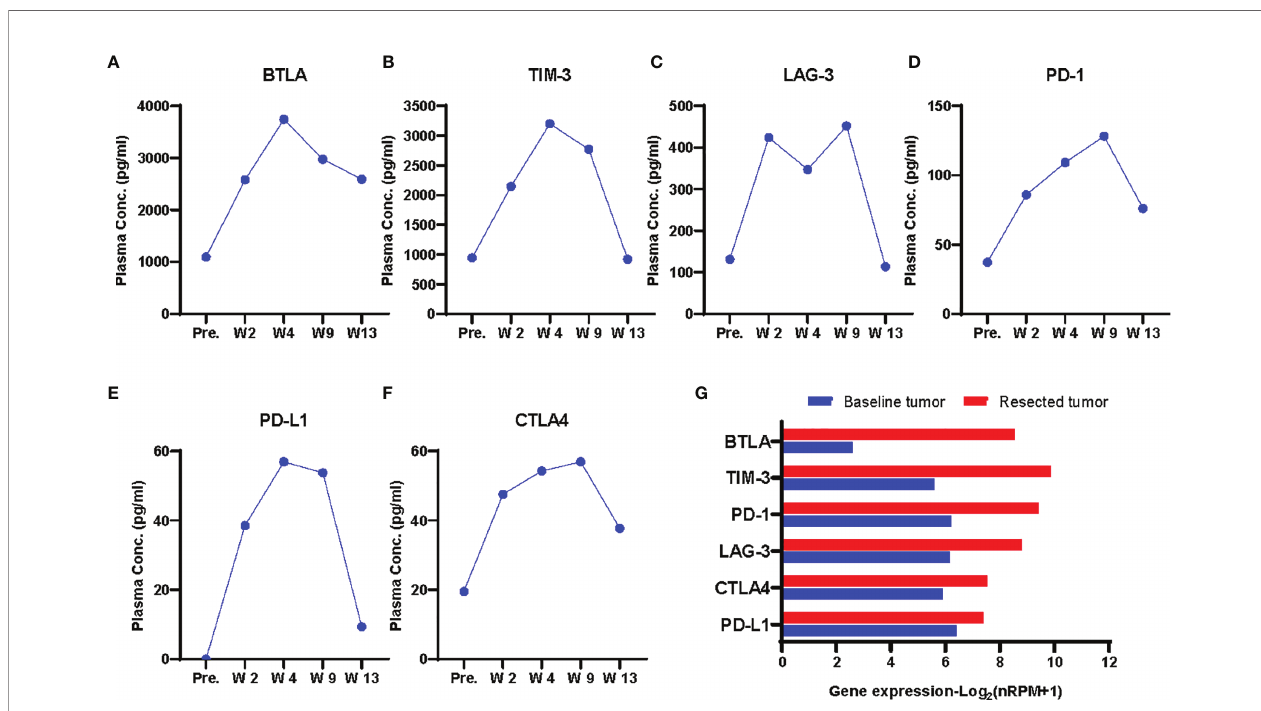
FIGURE 3 | Dynamics of plasma immune checkpoint proteins. (A – F) Plasma concentrations of checkpoint proteins BLTA (A) , TIM-3 (B) , LAG-3 (C) , PD-1 (D) , PD-L1 (E) ,CTLA4 (F) at each time point. pre., W2, W4, prior to each cycle of immunotherapy; W9, prior to the radical surgery; W13, four weeks after surgery. The proteins were upgregulated during immunotherapy treatment. (G) Gene expression of the immune checkpoint proteins in pre- and post-treatment tumor by RNA